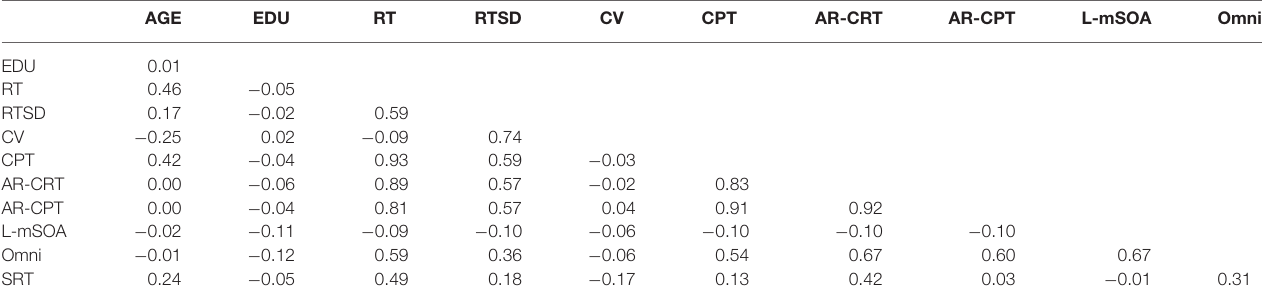
TABLE 3 | Correlation matrix for Experiment 1 .